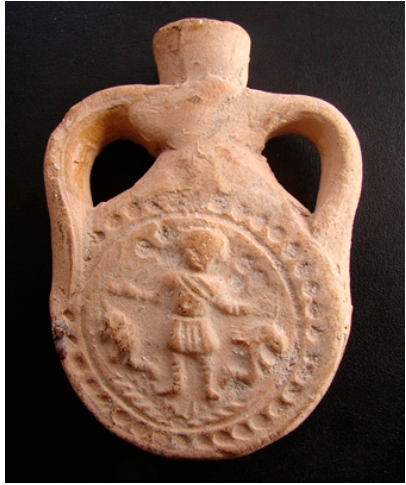
Figure 29. Pilgrimage flask with the image of Saint Menas. © Tarragona, Museu Bíblic (with kind permission).